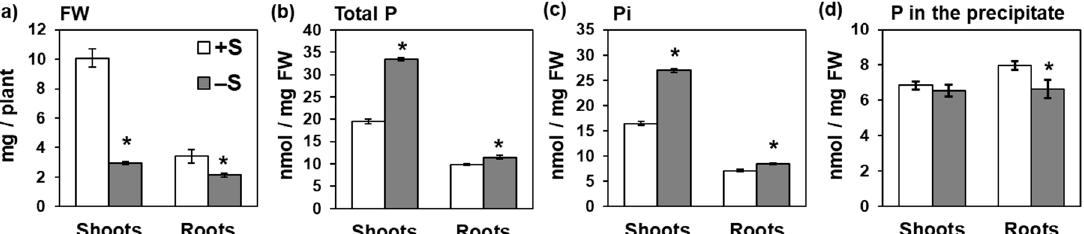
Figure 1. Sulfur deficiency increased phosphate (Pi) accumulation in Arabidopsis . ( a ) Fresh weights (FW), ( b ) total phosphorus (P) concentration, ( c ) Pi concentration, and ( d ) P concentration in the precipitate in shoots and roots of wild-type plants. Plants were grown for 10 days on MGRL agar media supplemented with 1500 µ M (sulfur su ffi ciency ( + S), white bar) or 15 µ M sulfate (sulfur deficiency ( − S), gray bar). In ( b ), plant samples were directly digested with concentrated nitric acid. In ( c ) and ( d ), plant tissues were extracted using 10 mM HCl. Then after transferring the supernatant to a new tube, the precipitate was digested with concentrated nitric acid. Digested plants ( b ), supernatant ( c ), and digested precipitate ( d ) were analyzed by ion chromatography. Bars and error bars indicate mean ± SE ( n = 4). Asterisks indicate significant di ff erences between + S and –S detected by Student’s t -test (* p < 0.05).